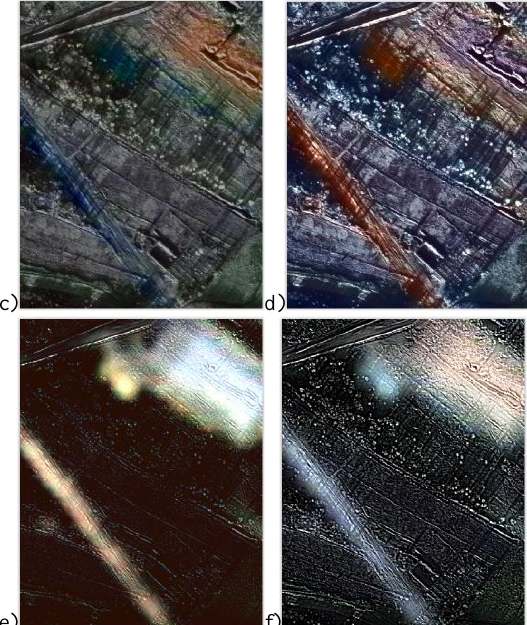
Figure 6. Results of pan-sharpening of the open area image based on: Brovey’s (a), Multiplicative (b), PCA (c), IHS (d), Ehler’s (e), HPF (f) methods Apart from data fusion method, none of the pan-sharpened images of open area is satisfactory. On each image, a colour distortion is a visible, especially for the road. Due to the fact Figure 5. Results of pan-sharpening of the forest area image that the multispectral imagery acquired by Landsat 8 was made based on: Brovey’s (a), Multiplicative (b), PCA (c), IHS (d), five years later than the Eros B imagery, some changes in the Ehler’s (e), HPF (f) methods land cover are noticeable. One of them is an industrial hall which is visible in the north-eastern part of the Figures 6. For the wooded hills, the best results were obtained with the Brovey's and multiplicative methods. In cases the PCA and IHS The results of the visual assessment have been verified using method, the biggest colour distortion have been noted for the statistical indicators. In this order, correlation coefficient, low buildings, which are situated in the north-eastern part relative mean error between pixel density and sharpened image of figures. Similar to the high urban area, the worst results were multispectral (R-RMSE) and ERGAS were used. Above obtained for Ehler’s and HPF methods. Despite increasing the indicators of quality have been designated in the Modeler tool spatial resolution, pan-sharpened images appear as blur, with of ERDAS IMAGINE 2013 software. a low resolution. In addition, the pan-sharpened image generated with the Ehler’s fusion is characterized by colour distortion.